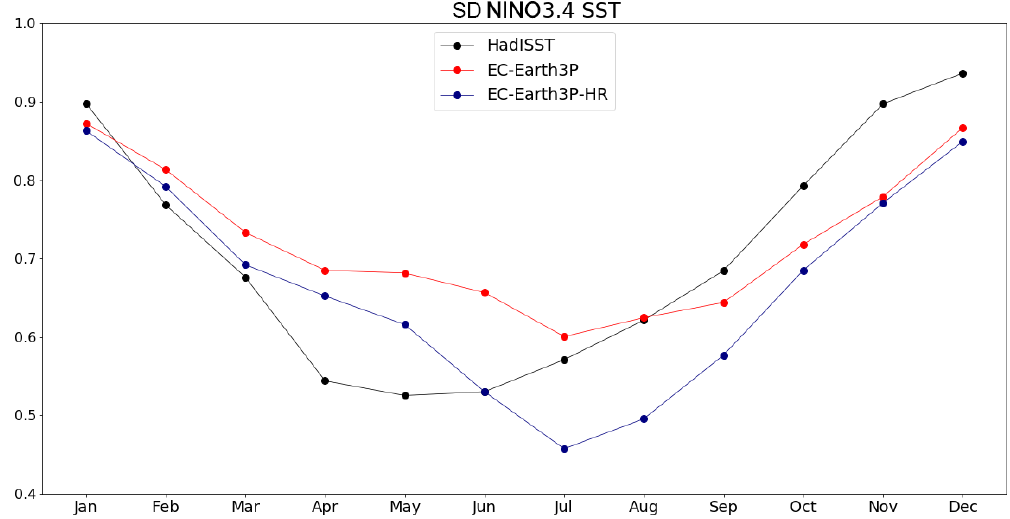
Figure 13. Monthly standard deviation of the NINO3.4 SST index: EC-Earth3P (red) EC-Earth3P-HR (blue) from control-1950 and de- trended Hadley Centre Sea Ice and Sea Surface Temperature data set (HadISST) over 1900–2010